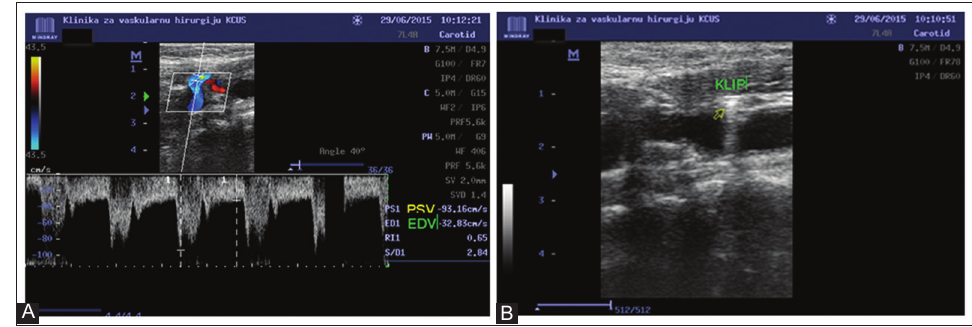
FIGURE 2. Control color Doppler (A) without repercussions on the flow, (B) no existence of a berry aneurysm.